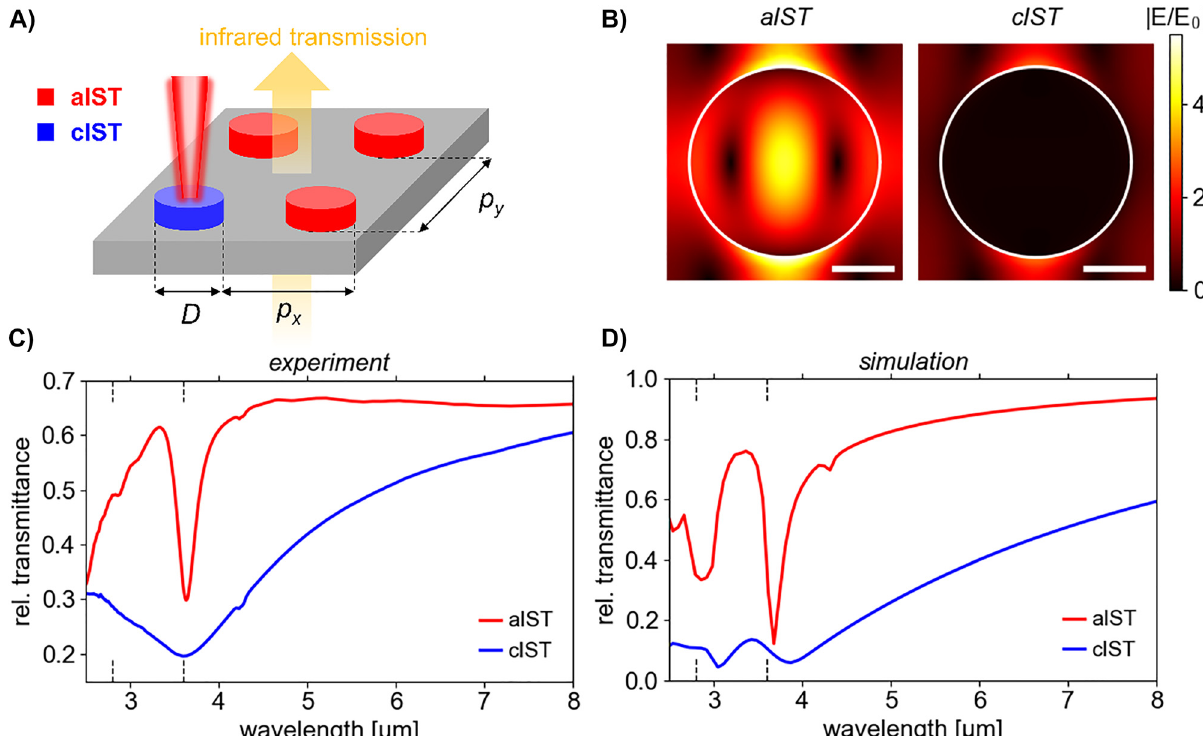
Figure3: ResonancewidthtuningwithnanostructuredISTdiskantennas.(A)SketchoftheISTnanodiskarraygeometry,infraredillumination, andtheopticalcrystallizationoftheantennas.(B)SimulatednormalizedabsoluteelectricfieldsoftheISTnanodisksinresonanceinthecross- sectionplaneathalf-heightoftheISTcore.Thescalebaris500nmlong.Theantennaboundaryisshownwithawhitecircle.(C)Measuredand (D) simulated transmittance spectra of the disk antenna array in its aIST (red) and cIST (blue, optically crystallized) states. The dashed black linesintheplotsat the x -axismarkthepositionof the fi rst ordergrating resonances throughair andCaF 2 (an averageangle of incidenceof 15 ° is